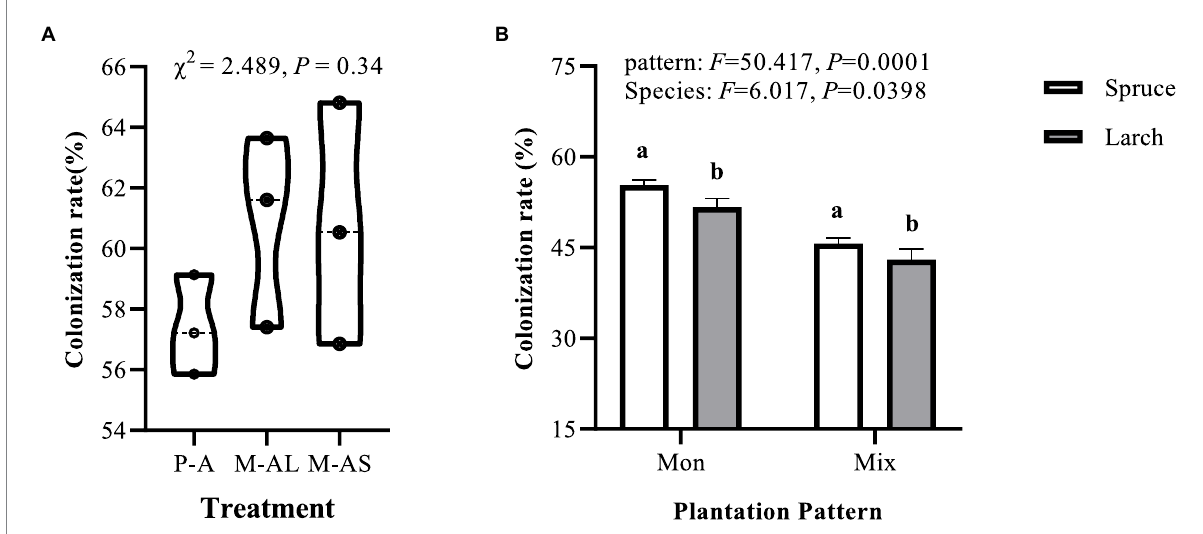
FIGURE 1 Colonization rate of arbuscular mycorrhizal fungi (A) and ectomycorrhizal fungi (B) in stands of monocultures and mixtures at the Maoershan Experiment Station, Northeast China. M-AL, Ash-Larch mixture; M-AS, Ash-Spruce mixture; P-L, Larch monoculture; P-S, Spruce monoculture. Mon, monoculture; Mix, mixture. All values represent mean ± standard error (SE), with three replicates per treatment . Different lowercase letters indicate significant differences between different stands according to Tukey’s honestly significant difference test ( α = 0.05).